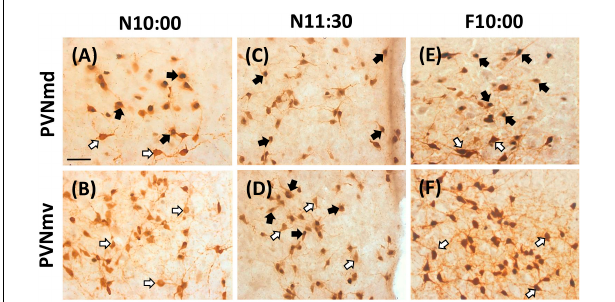
FIGURE 3 | Expression of OT- and Fos-ir in PVNmd and PVNmv in nursed (N10:00 and 11:30) and fasted (F10:00) subjects. Photomicrographs of representative sections of PVNmd (A) and PVNmv (B) just before nursing (10:00) and 1.5 (C,D) h after. Note an increase in double labeled Fos-/OT-ir cells in the NPVmd (A) just before nursing, which persist in fasted subjects at the time of the previous scheduled time of nursing (E) . On the contrary a similar increase is observed in the PVNmv 1.5 h but after (D) , not before (B) nursing, which does not persist in fasting (F) . Scale bar, 50 µ m.